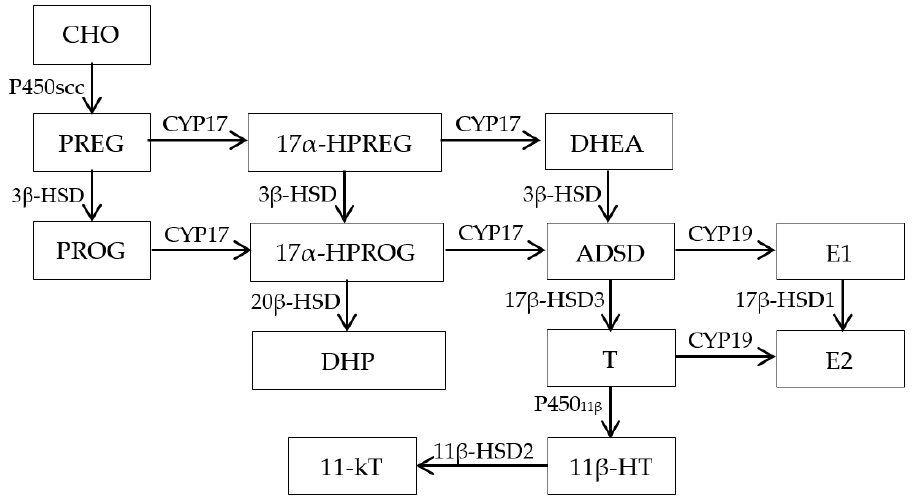
Figure 2. The sex hormone biosynthesis pathway in fish. (Note: CHO (Cholesterol), PREG (Preg- nenolone), PROG (Progesterone), P450scc (Cholesterol side chain cleavage enzyme/CYP11A1), 3 β -HSD (3 β -hydroxysteroid dehydrogenase), CYP17 (Cytochrome P450 17 α -hydroxylase), 17 α - HPREG (17 α -Hydroxypregnenolone), 17 α -HPROG (17 α -Hydroxyprogesterone), DHEA (Dehy- droepiandrosterone), ADSD (Androstenedione), 17 β -HSD1 (17 β -hydroxysteroid dehydrogenase type I), 17 β -HSD2 (17 β -hydroxysteroid dehydrogenase type II), 17 β -HSD3 (17 β -hydroxysteroid dehydrogenase type III), E1 (Estrone), E2 (17 β -estradiol), T (Testosterone), 11-KT (11-ketotestosterone), 11 β -HT (Hydroxytestosterone), DHP(17 α ,20 β -dihydroxy Progesterone)).